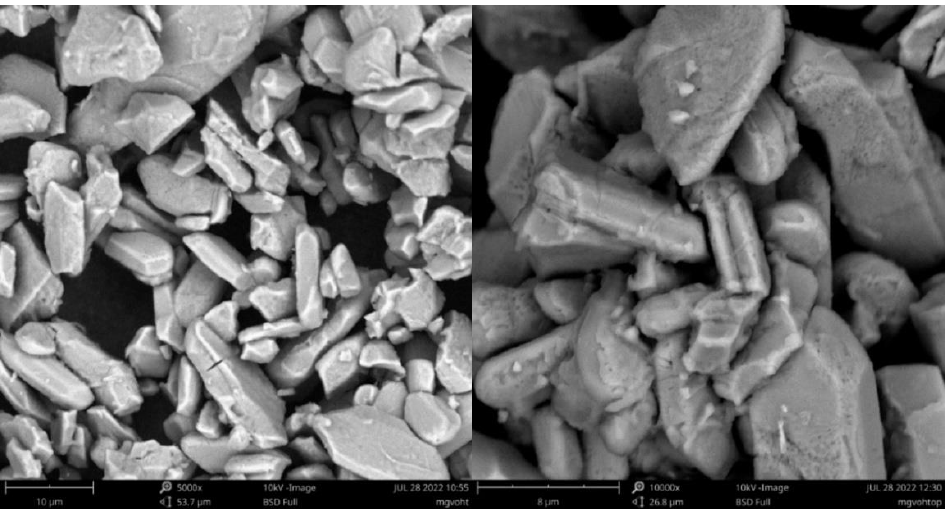
Figure 3. SEM micrographs of MgVO-LT ( up ) and MgVO-HT ( down ). Based on the morphological observations, the polyphase material